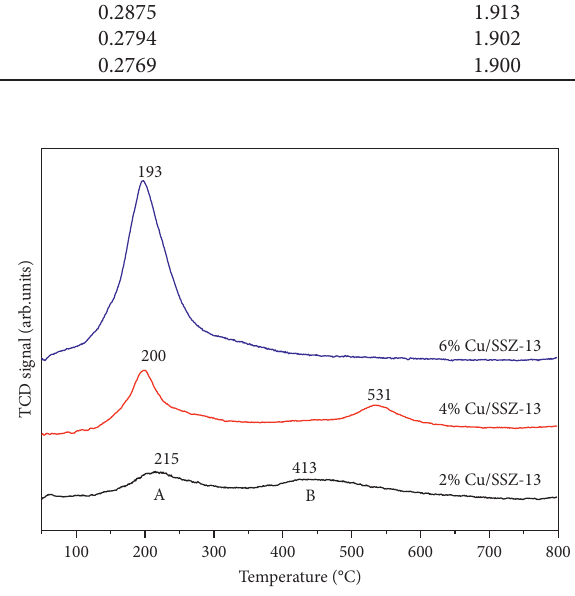
Figure 4: TPR patterns of x Cu/SSZ-13 ( x � 2, 4, and 6%) catalysts.